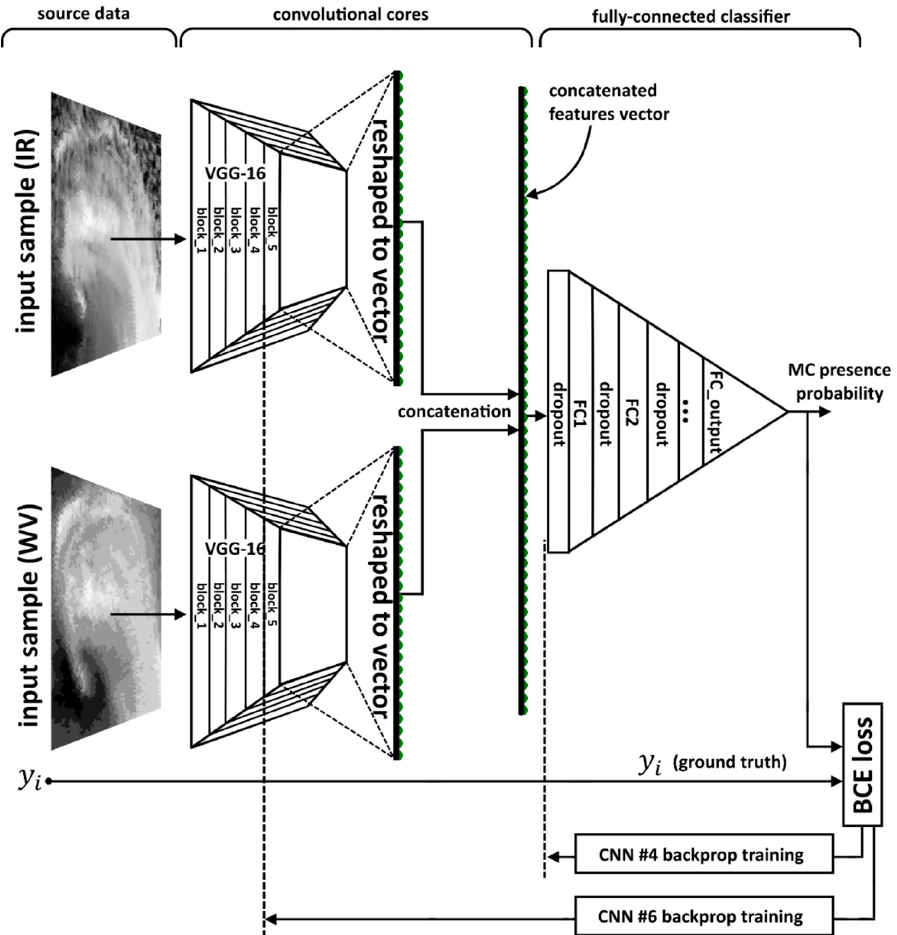
Figure 4. CNN #4 and CNN #6 structures. The dots along the “reshaped to vector” and “concatenated features vector” lines denote elements of convolutional cores outputs reshaped to vectors, which are, being concatenated to a combined features vector, the fully-connected classifier input data.